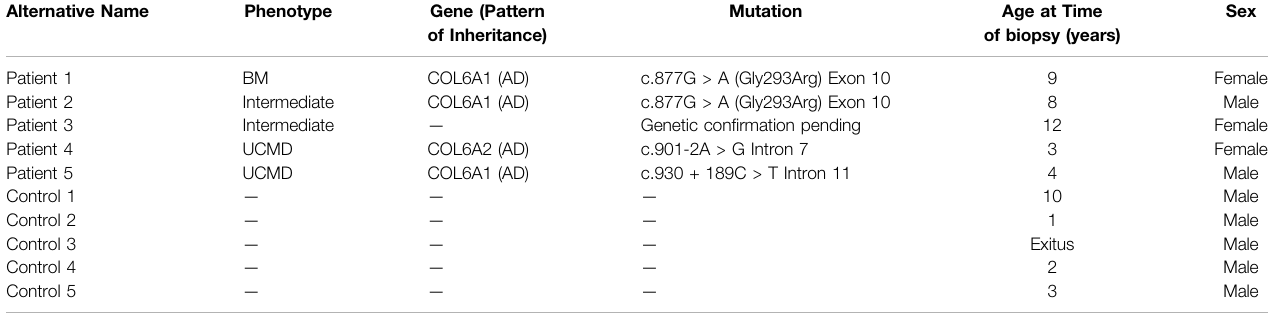
TABLE1| ControlandCOL6-RDdonorsincludedinthestudy.Thetabledescribesanonymouslyeach fi broblastdonorwithdetailsonthephenotypeofthepatientsandthe genetic background.